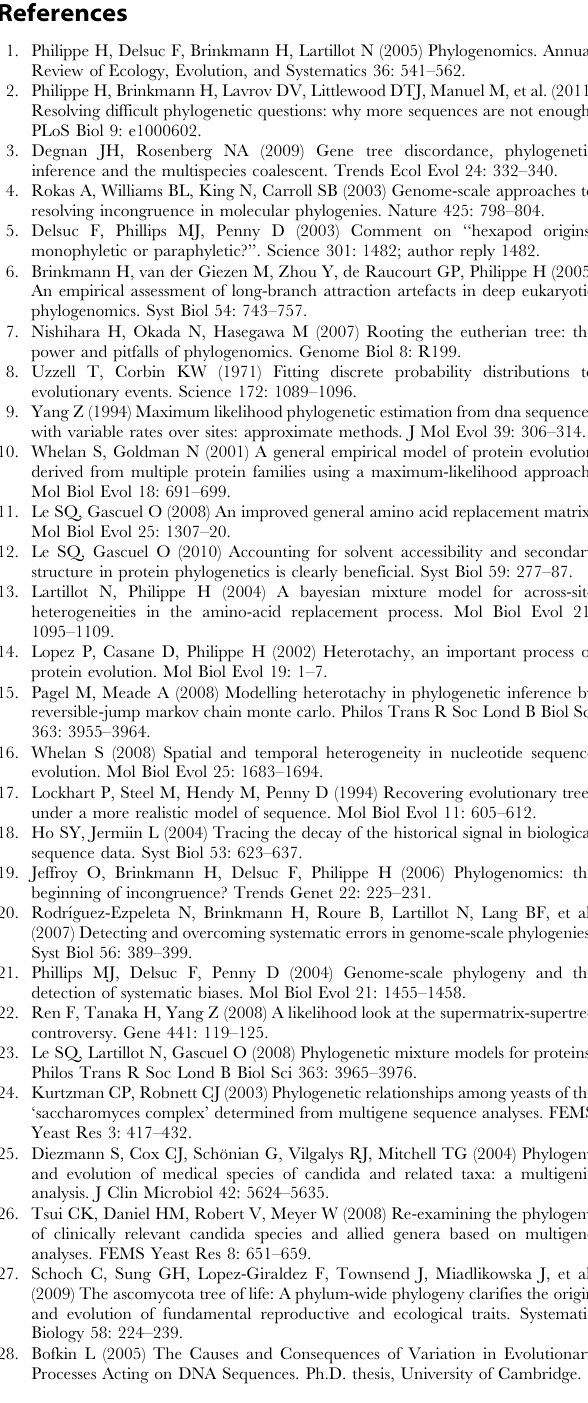
Figure S4 Supermatrix ML trees recovered using non- optimal evolutionary models. Lettering corresponds to the labels used in Table 1 and Figure 4 in the main text. Bootstrap values are indicated as a percentage out of 1000 replicates using RELL resampling (see Methods in main text). Text S1 Additional analyses investigating the effects of model choice and between-gene heterogeneity in the single-gene